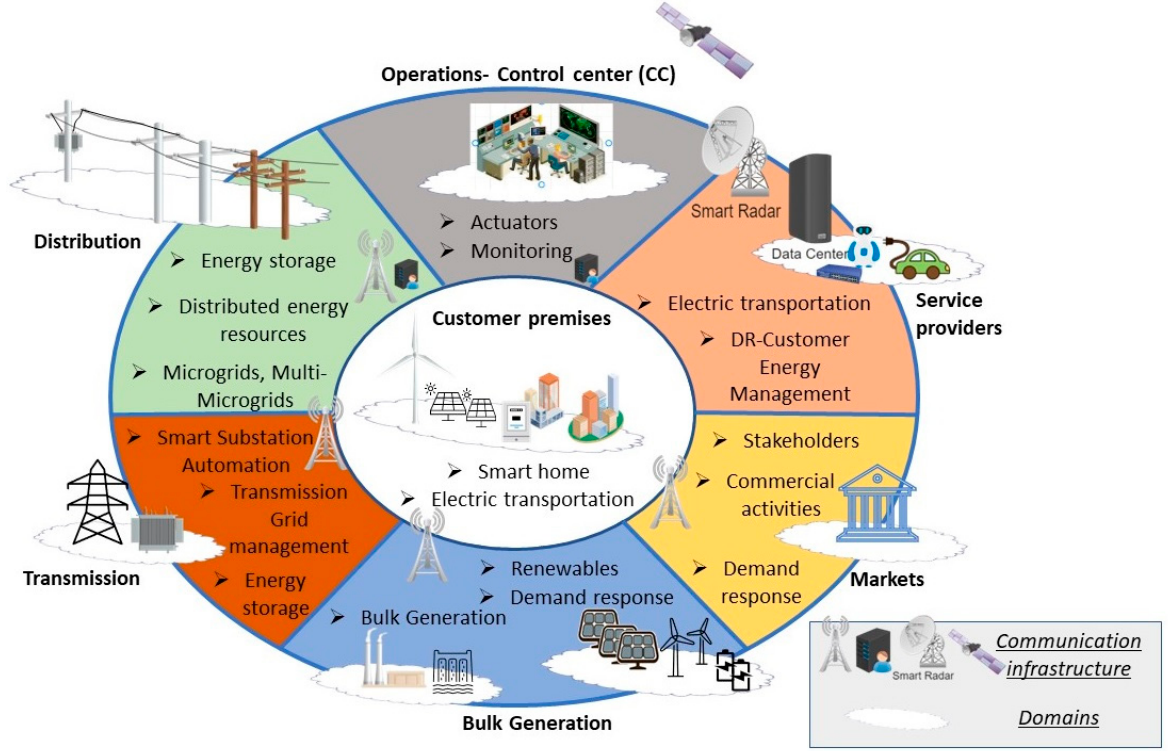
Figure 1. Smart Grid Domains. Vision for Smart Grid [8].